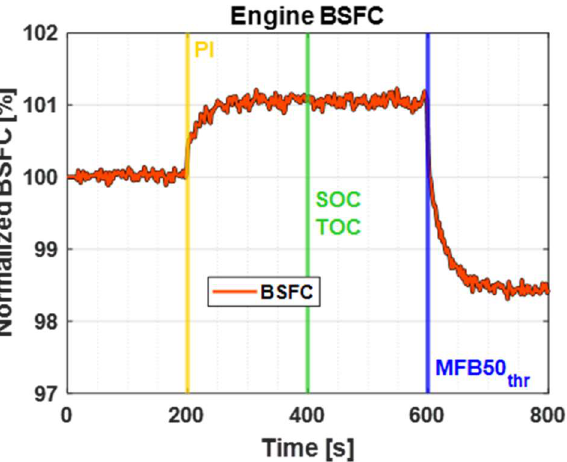
Figure 17. Behavior of BSFC when the combustion controller strategies are activated in succession at 1800 rpm and 100% pedal.